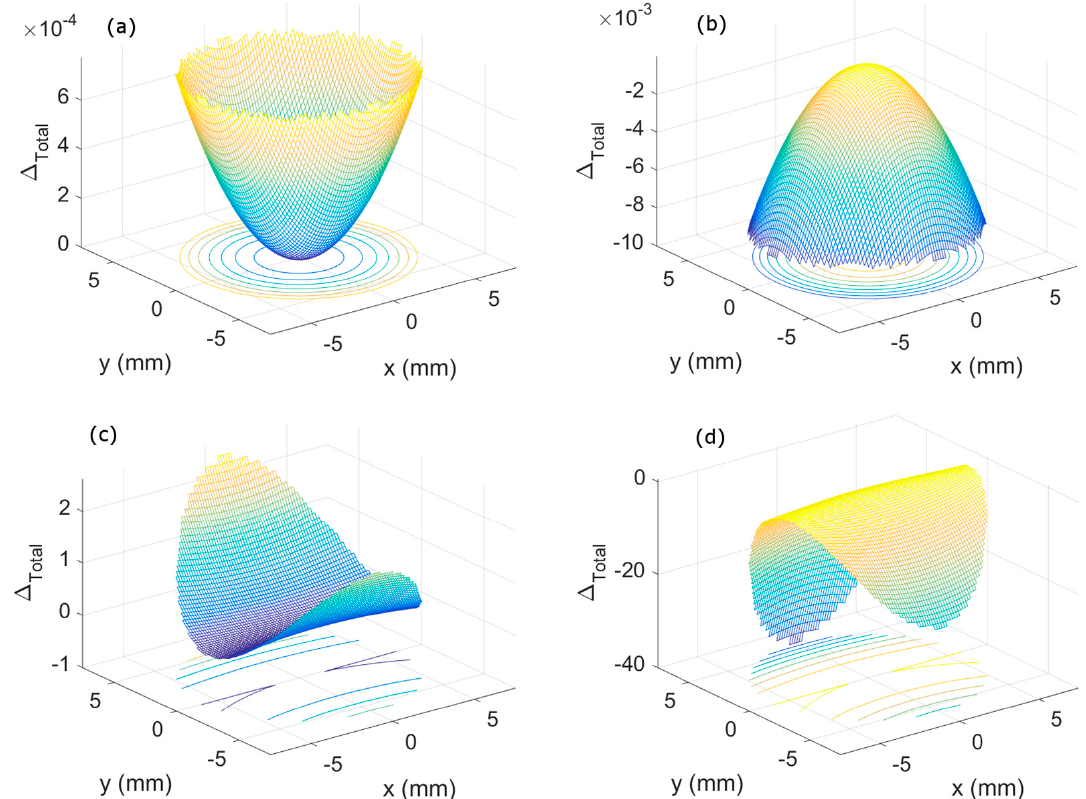
Figure 5. Total aberration ( Δ Total ) at the exit pupil plane (PS) of asymmetrical, ( a ) and ( b ), and symmetrical, ( c ) and ( d ), HLs recorded ( a ) and ( c ) at 473 nm and ( b ) and ( d ) at 633 nm wavelength.